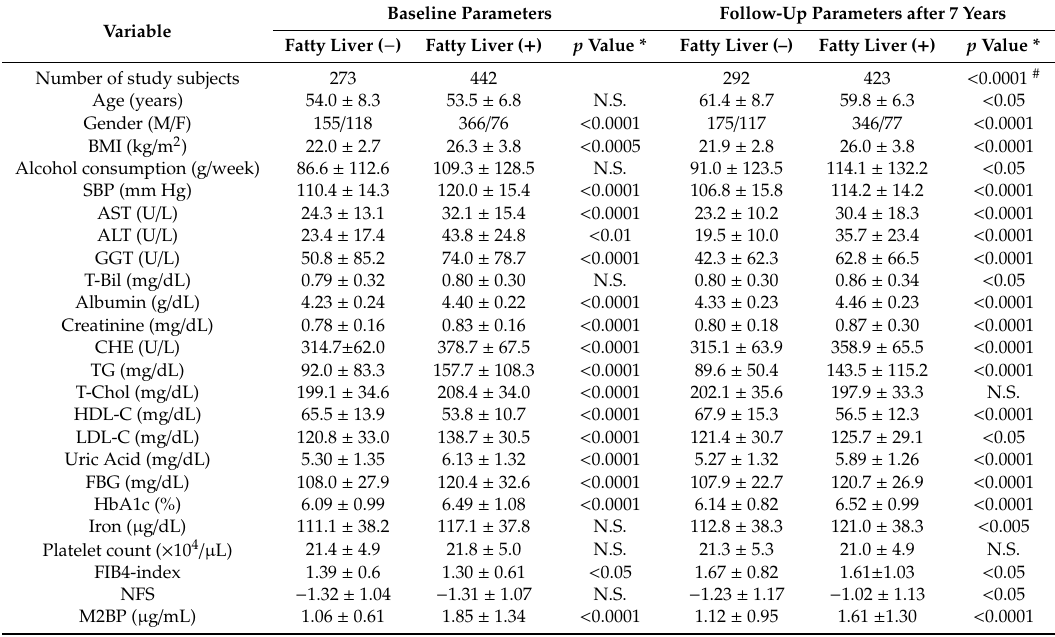
Table 1. Clinical and biochemical parameters of study